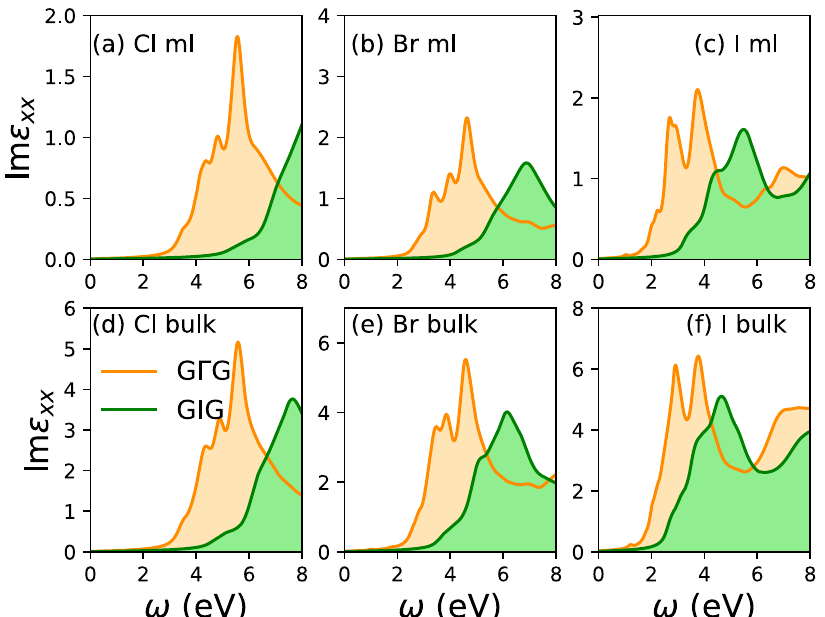
Fig. 1 Optical response in bulk and monolayer. Imaginary part of macroscopic dielectric response Im ϵ xx with the perturbing electric fi eld applied along the (100) direction of the material, for free-standing monolayers (ml) of CrX 3 with ( a ) X = Cl, ( b ) X = Br, ( c ) X = I and bulk CrX 3 with ( d ) X = Cl, ( e ) X = Br, and ( f ) X = I. The orange color stand for QS G b W vertex Γ corrected optical response, while the green color stands for the vertex replaced by an identity matrix I effectively making it a RPA optical response with QS G b W one-particle eigenfunctions. Energy- dependent optical broadening that linearly varies from 2 milli-Hartree at ω = 0 and 50 milli-Hartree at ω = 13.6 eV is used.